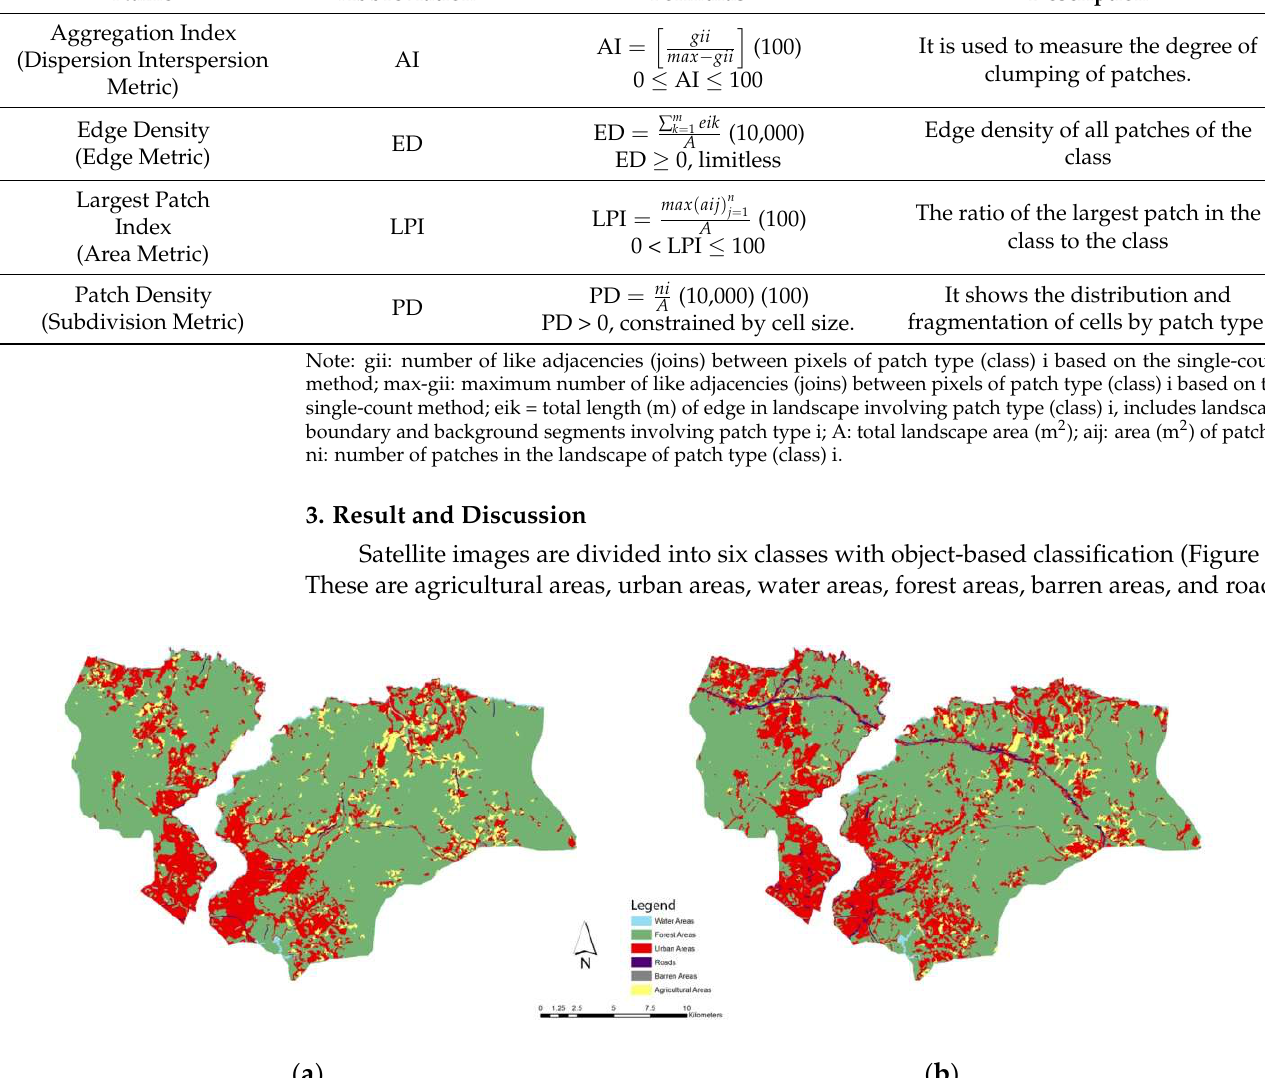
Table 4. Result of accuracy assessment.